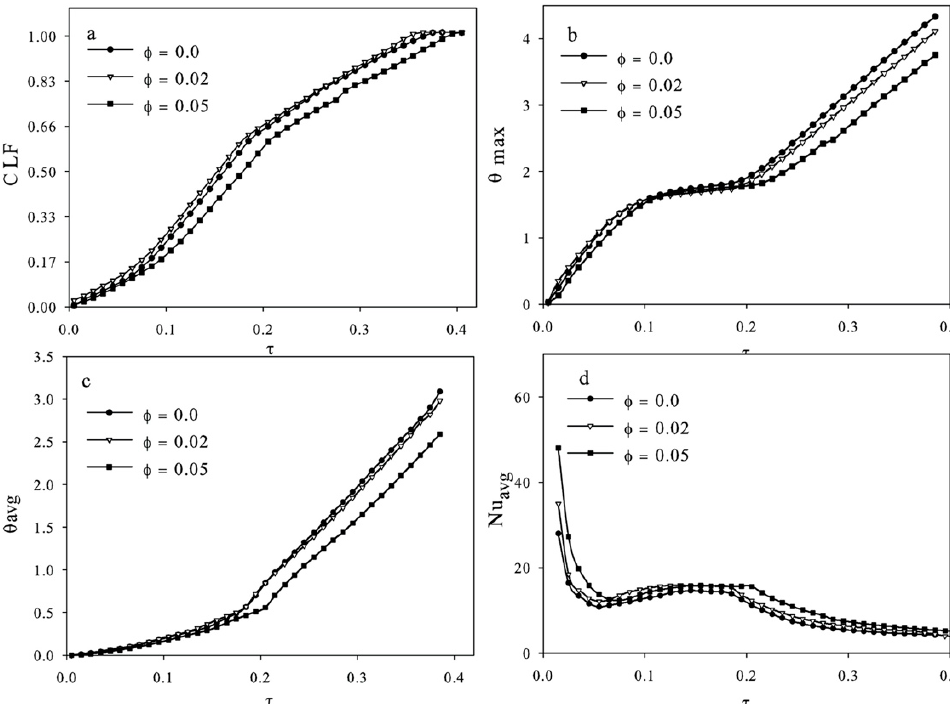
Figure 6. The graphs show little/no improvement with the addition of NPs in the Farsani et al. study Figure 6. ( a ) liquid fraction, ( b ) average dimensionless temperature, ( c ) maximum dimensionless (Copyright 2017 Elsevier) [34]. tempera-ture, and ( d ) average Nusselt number in in the Farsani et al. study (Copyright 2017 Else- vier)